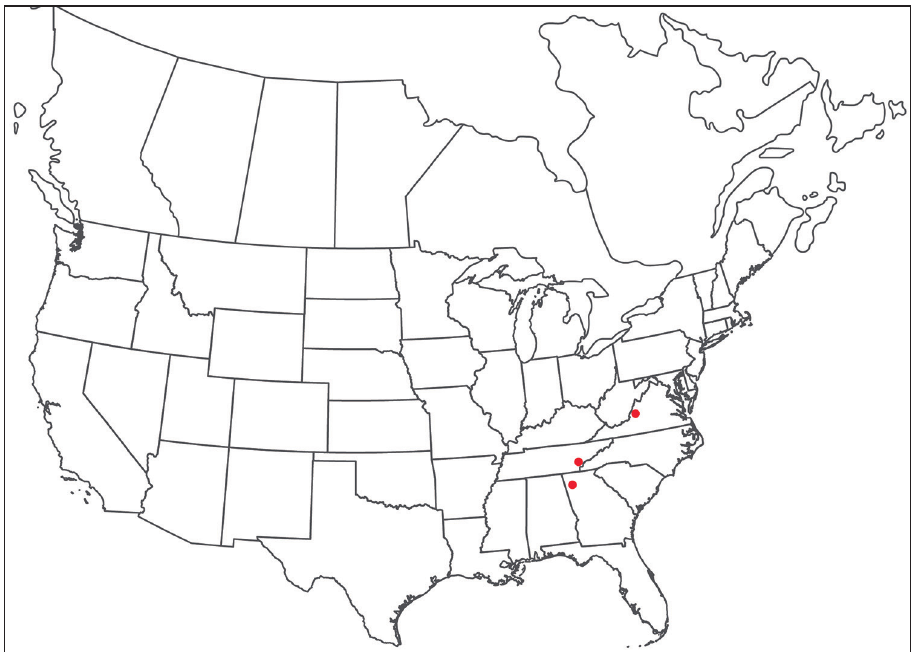
Figure 53. Torrenticola dentirostra sp. n.